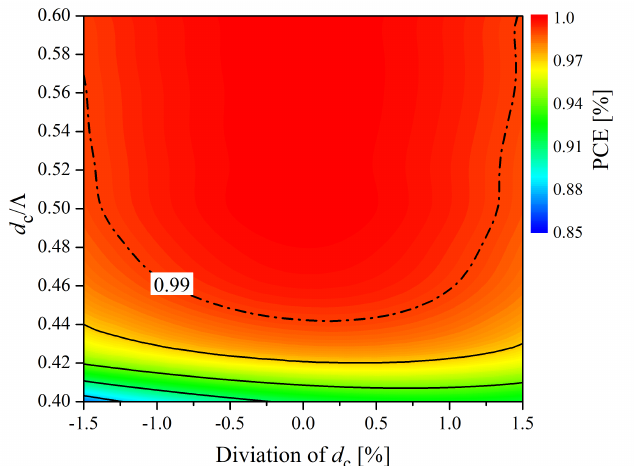
Figure 8. The variation of the PCE as a function of the deviation of hole diameter with different hole